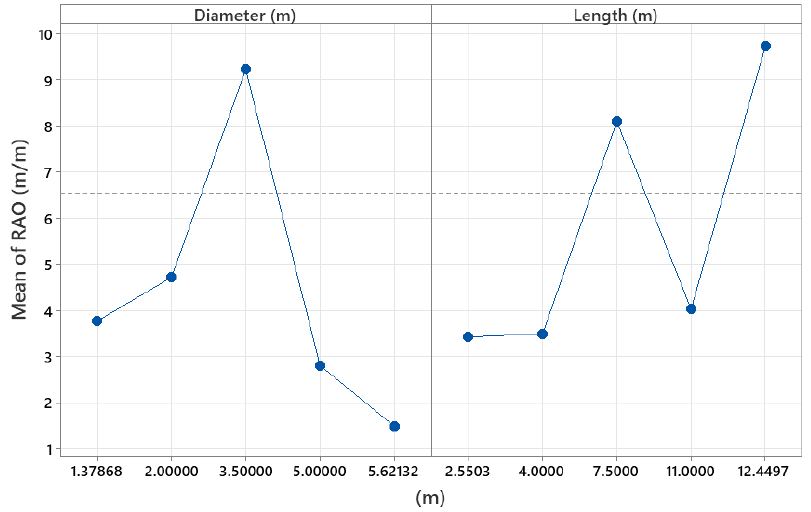
Figure 15. Main Effect Diagram for Heave RAO.